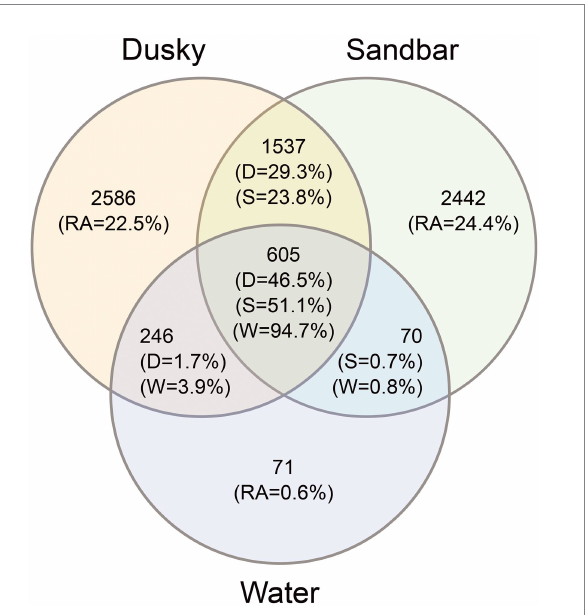
FIGURE 3 Venn diagram showing the number and relative abundance (RA) of unique and shared ASV’s among dusky sharks (D), sandbar sharks (S) and their surrounding seawater